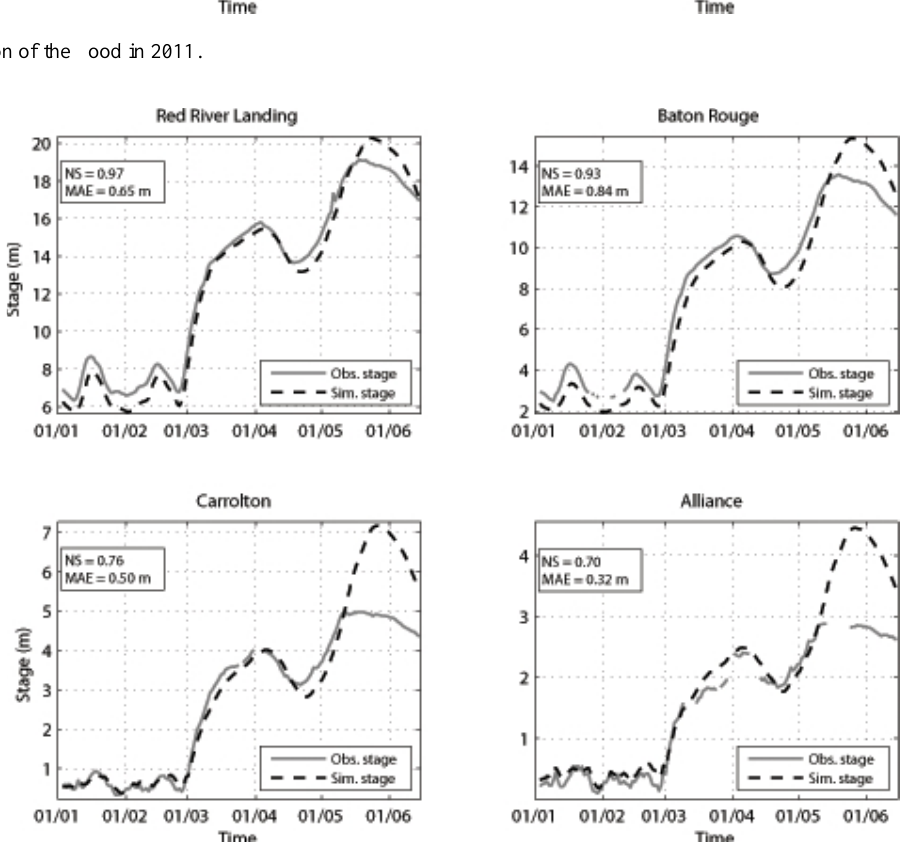
Figure 4. The validation of the flood in 2011 when no spillways are opened.